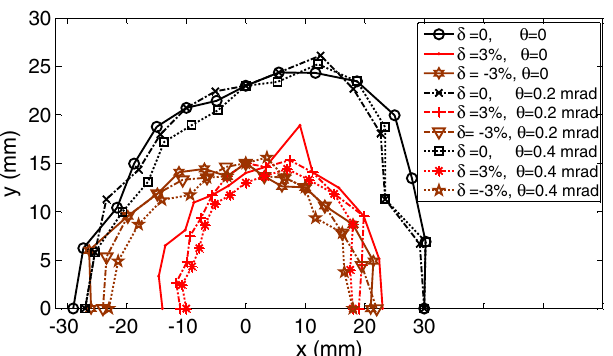
FIG. 7. Dynamic apertures for on-momentum and off-momen- tum beams for different operating modes (blue lines indicate on-momentum particles and green and red lines indicate off- momentum